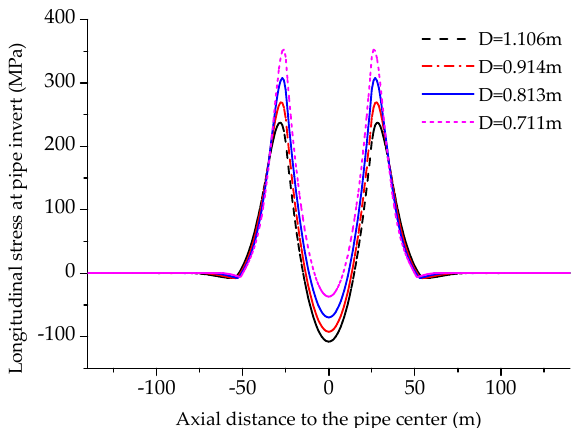
Figure 13. Longitudinal stresses at pipe invert for pipes with various diameters.